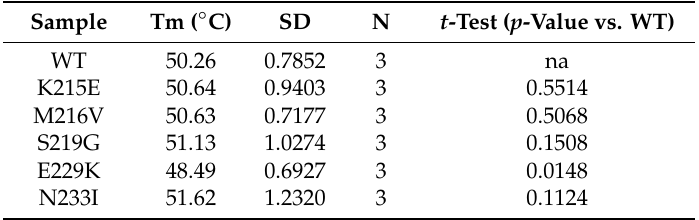
Table 6. The melting temperature (Tm) of the wild-type and mutated BAG-1 variants were calculated by fitting the thermal shift assay data using the Boltzmann equation. The values are presented as the averages of three independent experiments. A student’s t -test determined statistical significance. A p -value < 0.05 was considered statistically significant. SD: standard